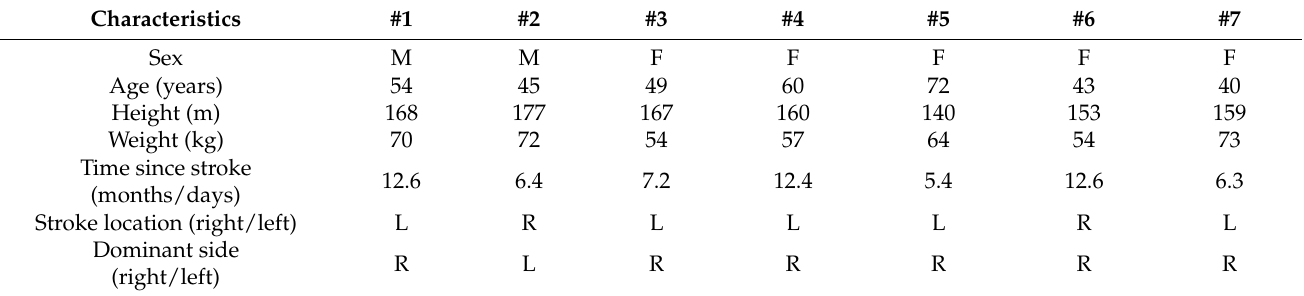
Table 1. Demographic information of the study